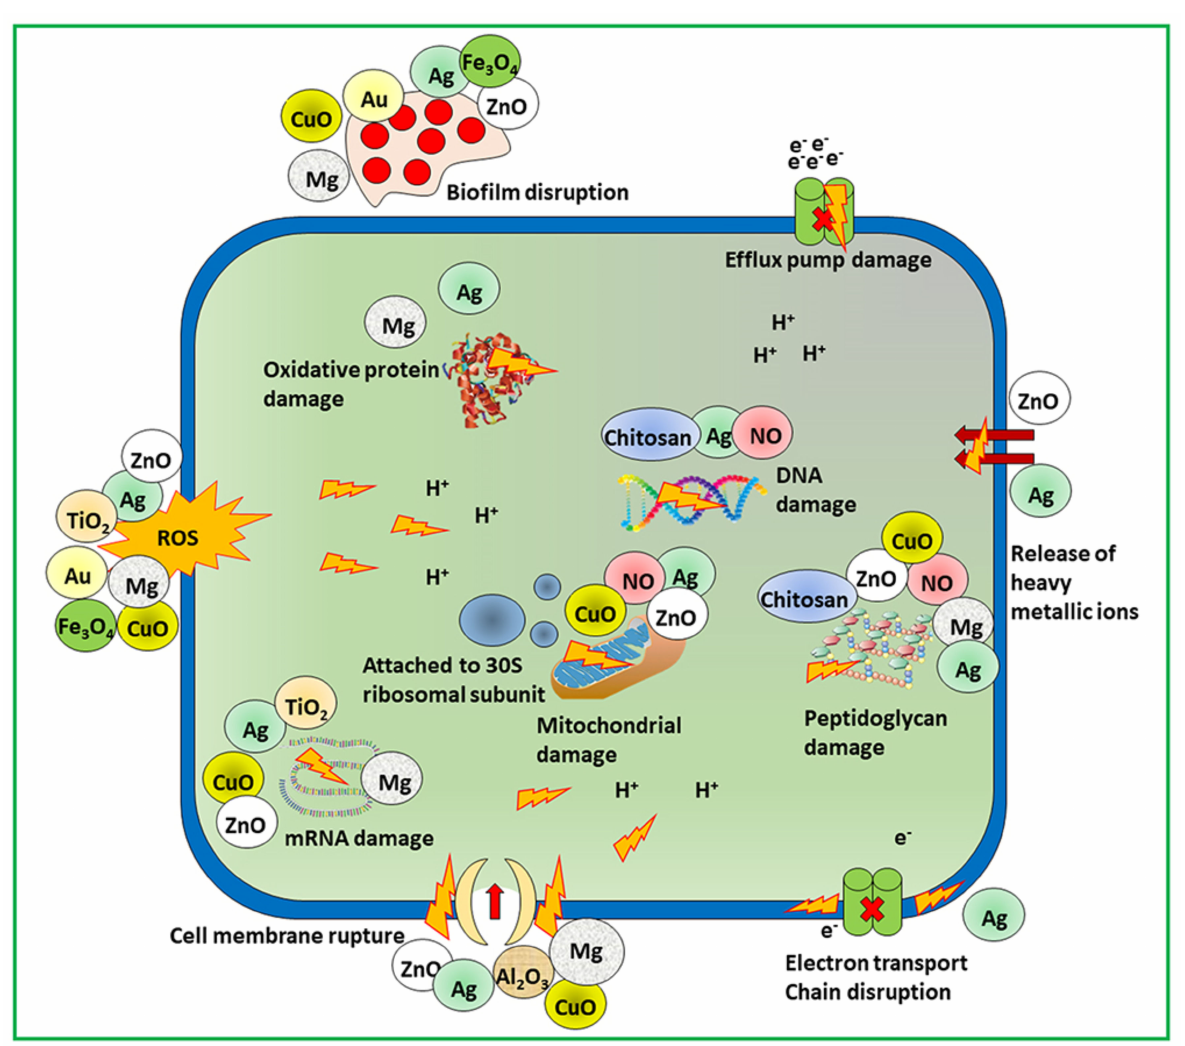
Figure 2. Scheme of mechanistic action of antimicrobial materials to combat microbial resistance. Adapted from [6], Dove Medical Press,